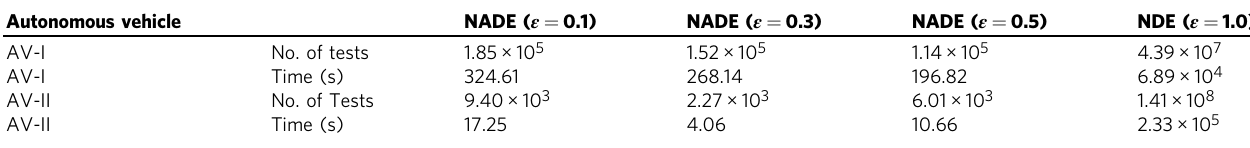
Table 1 The average minimum number and average wall-clock time of tests in the naturalistic driving environment (NDE) and the naturalistic and adversarial driving environment (NADE) with different parameters ε = 0.1, 0.3, 0.5 for reaching the precision threshold (RHW is